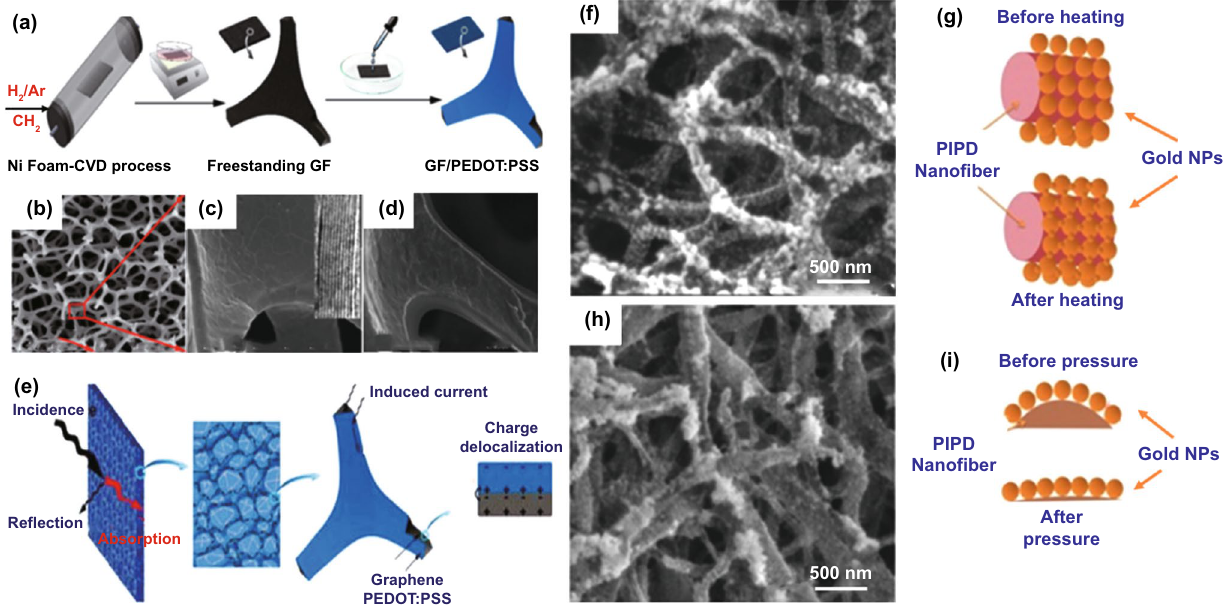
Fig. 13 a Schematic procedure of the preparation of GF/PEDOT:PSS composites. SEM and TEM images of GFs b, c before and d after PEDOT:PSS coating. e Schematic illustration of EMI shielding mechanisms [134]. Copyright © 2017 American Chemical Society. f-i SEM images of the PIPD-g-PDDA/Au6 composites; scheme of the gold network changes during the heating process; SEM images of the PIPD-g- PDDA/Au6 composites pressed at 3 MPa for 2 h; Scheme of the gold network changes during the pressing process [136]. Copyright © 2017 Royal Society of